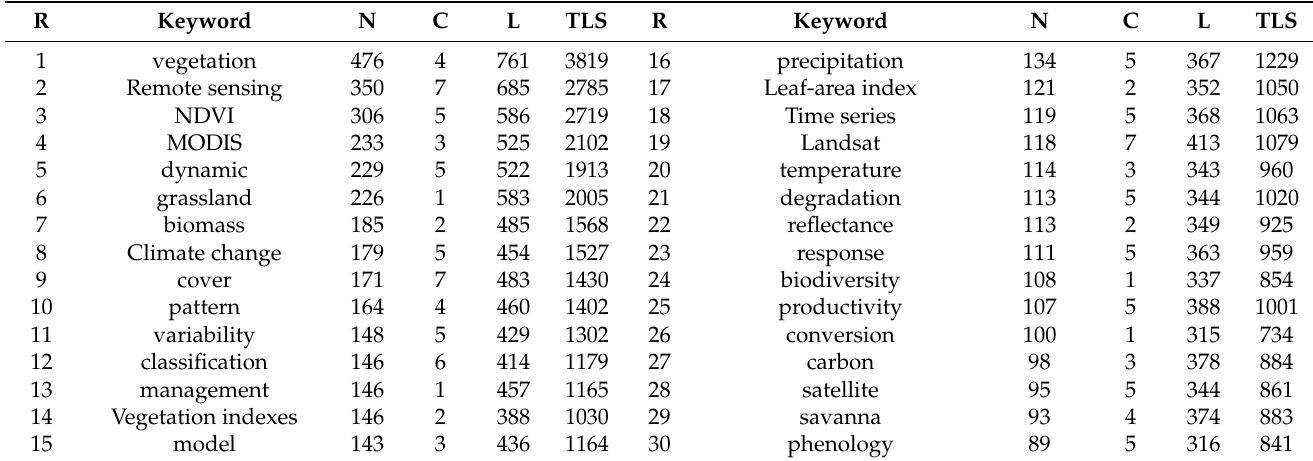
Table 5. Top 30 keywords on GRS research studies from 1980 to